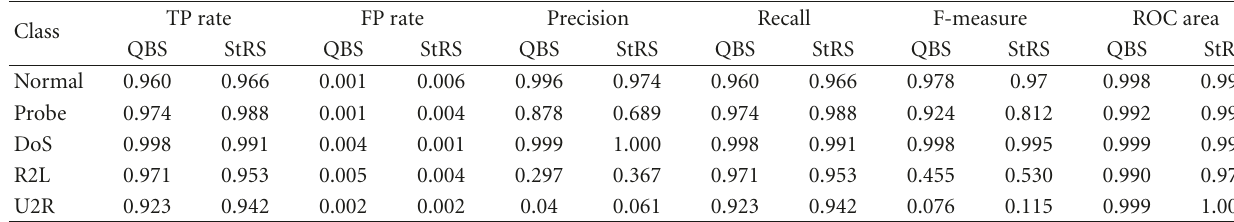
Table 3: Detailed accuracy by class of the training